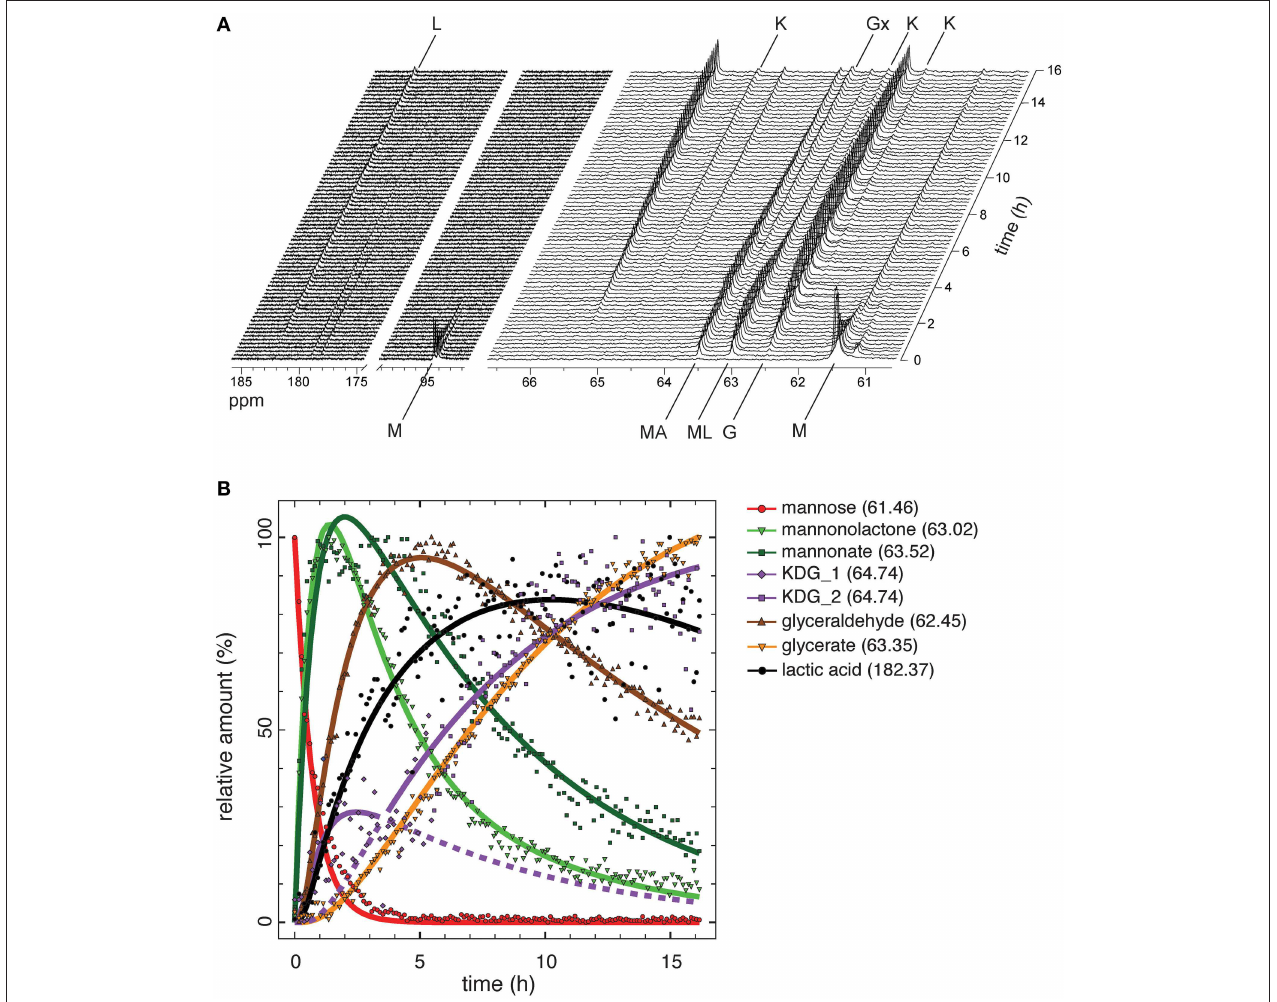
FIGURE 4 | Flux analysis of the reaction cascade using NMR. (A) Real-time 13 C NMR analysis of one-pot reaction performed with 10mM D-[1,6- 13 C 2 ]mannose and 10mM NAD + for 16h. M, mannose; MA, mannonate; ML, mannonolactone; K, KDG; G, glyceraldehyde; Gx, glycerate; L, L-lactic acid. (B) Relative amounts of the intermediates derived from integration of areas for characteristic chemical shifts for each intermediate. Only integrals for the lower chemical shift of C6 compounds were analyzed. Integrals were fitted using DynaFit 4.0 (Kuzmi ˇ c,